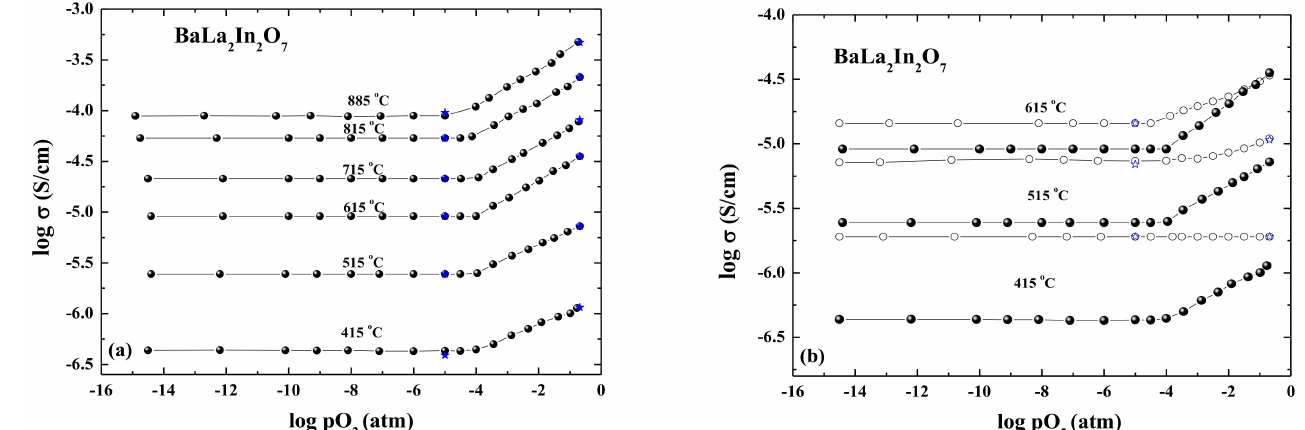
Figure 5. The dependencies of the conductivity values vs. p O 2 for the sample BaLa 2 In 2 O 7 at dry conditions ( a ) and dry (closed symbols) and wet (open symbols) conditions ( b ) (black symbols) and conductivity values from σ –10 3 / T dependencies at dry Ar (blue